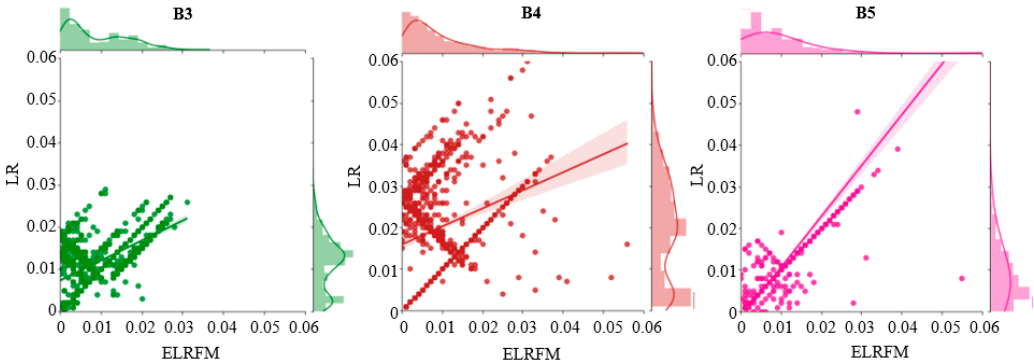
Figure 7. Distribution of the absolute difference between the observed and predicted reflectance from the LR and ELRFM in the green (B3), red (B4), and near-infrared (B5) bands.